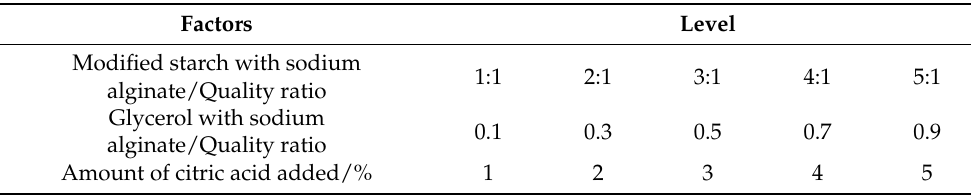
Table 1. Experimental design for the preparation of corn-starch–sodium-alginate-based liquid mulch. Factors Level Modified starch with sodium alginate/Quality ratio Glycerol with sodium alginate/Quality